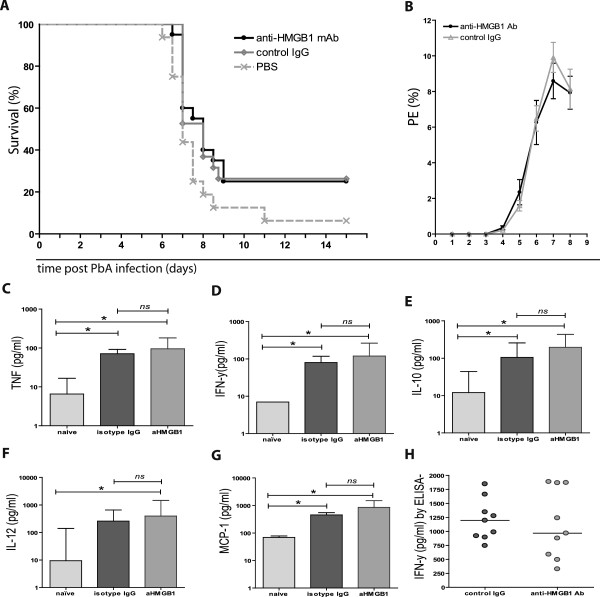
HMGB1 is not necessary or sufficient for the development of severe malaria following Plasmodium berghei ANKA (PbA) infection in the experimental murine model. (A) Kaplan-Meier survival analysis after C57BL/6 mice were infected with 1 × 106Plasmodium berghei-ANKA (PbA) infected erythrocytes. There was no significant difference in survival between mice receiving an HMGB1 neutralizing antibody (2G7) (black circle, solid line), or control IgG2b (grey diamond, solid line) (Log rank test, p = 0.9, median survival = eight days for both groups; n = 20/group) or PBS control (grey x, dashed line) (Log rank test, p = 0.06; n = 15). Data is pooled from two independent experiments. The kinetics of peripheral parasitaemia are shown up to day 9 post PbA infection for anti-HMGB1 2G7 treatment mice and isotype IgG control (B). Results expressed as a percentage of the parasitized erythrocytes (PE) and represent mean + SEM from one representative experiment (n = 10/group). Levels of TNF, IFN-γ, IL-10, IL-12 and MCP-1 were measured in serum collected from naïve, uninfected mice and PbA-infected mice on day 5 pi using the mouse cytometric bead array (C-G). Bars and whisker represent median and interquartile range (IQR). Statistical differences were assessed by Kruskal-Wallis one-way analysis of variance with Dunn’s multiple comparisons test. * indicates a p value of <0.05. Plasma levels of IFN-γ were confirmed by ELISA (H) and statistical difference between anti-HMGB1 2G7 and isotype IgG control was assessed by Mann–Whitney test (ns, p = 0.73). The line represents the median levels of all individual values in the scatter dot plot.